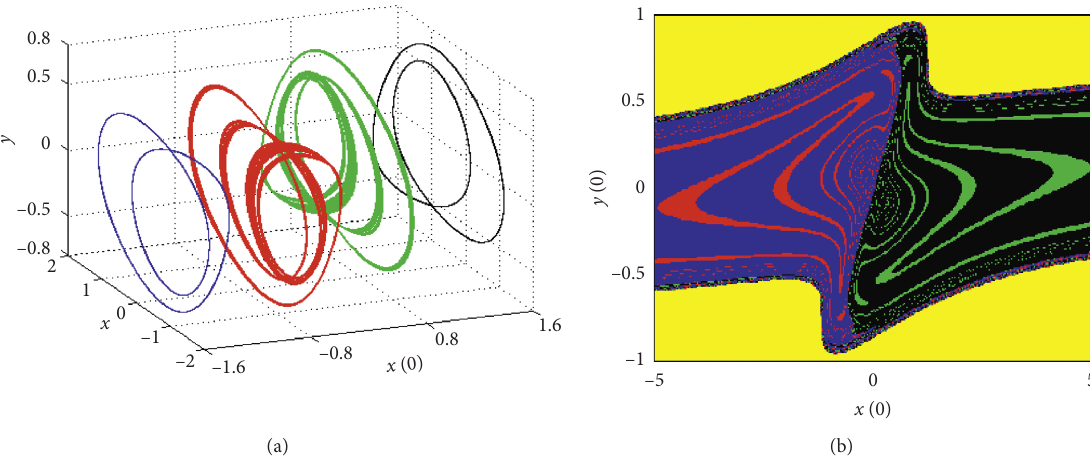
Figure 3: Three-dimensional projections of the coexisting attractors in the ( x ( 0 ) , x,y ) plane. (a) Coexistence of four different attractors (a pair of chaotic attractors and a pair of period-2 limit cycles) for β � 53 . 8. (b) Cross sections of the basin of attraction for z ( 0 ) � 0, corresponding to the asymmetric pair of period-2 cycles (black and blue) and the pair of chaotic attractors (red and green). Yellow regions correspond to unbounded